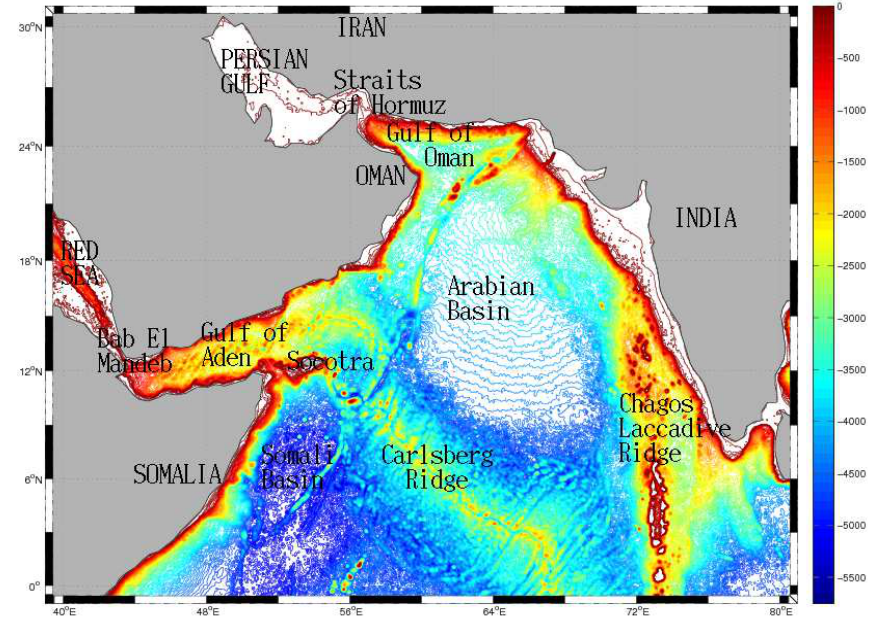
Fig. 1. Bathymetry of the Arabian Sea (from ETOPO1 Figure 1: Bathymetry of the Arabian Sea (from ETOPO1 database)